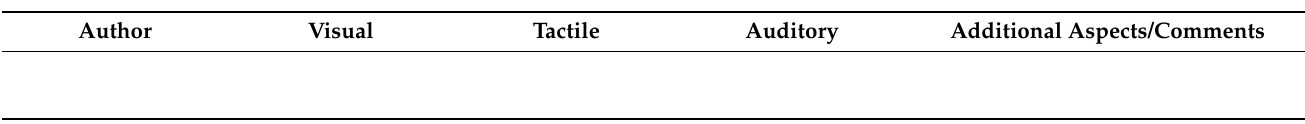
Table A2. Description of the intervention.